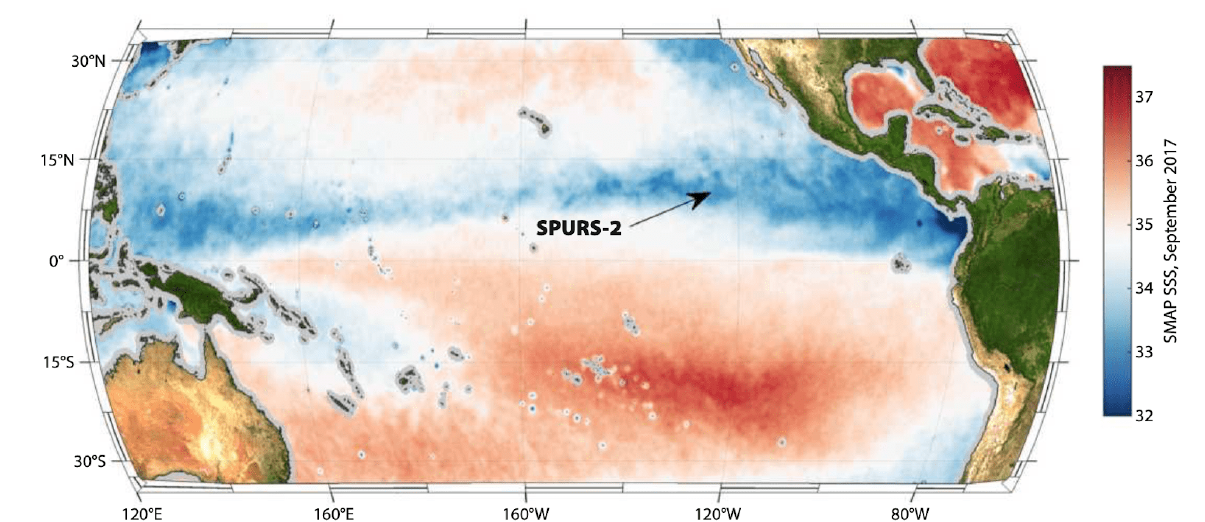
Figure 21. From [38], Sea surface salinity for the month of September 2017 from SMAP satellite data. The SPURS-2 site is indicated by an